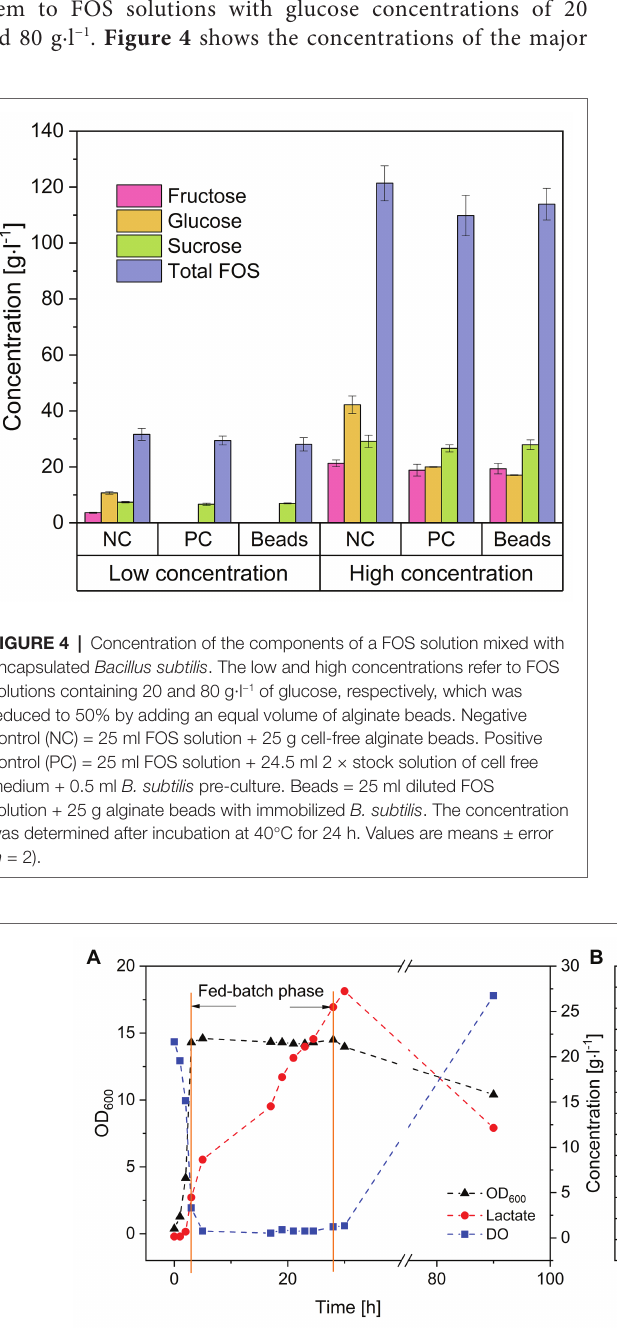
of FOS by the lactobacilli was detected after the depletion of monosaccharides.